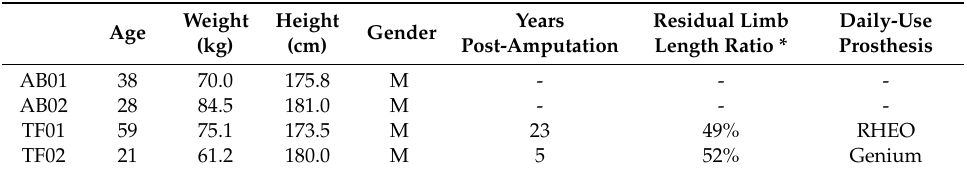
Table 1. Demographic information for able-bodied subjects (AB01 and AB02) and transfemoral amputees (TF01 and TF02).